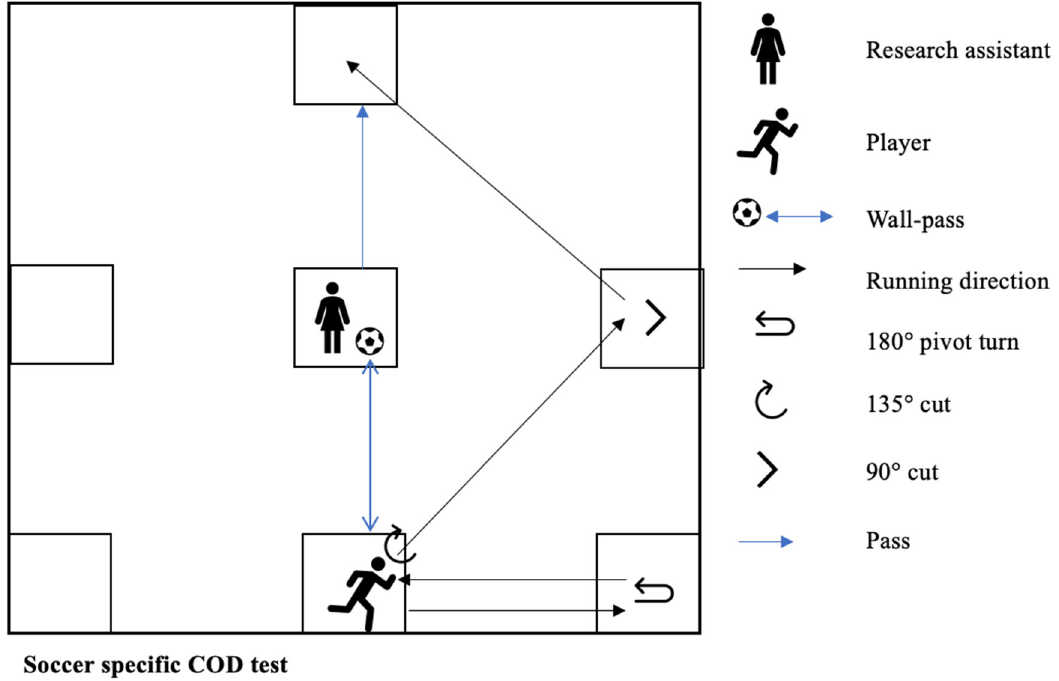
Figure 2. Map of the test, displaying cuts on the right